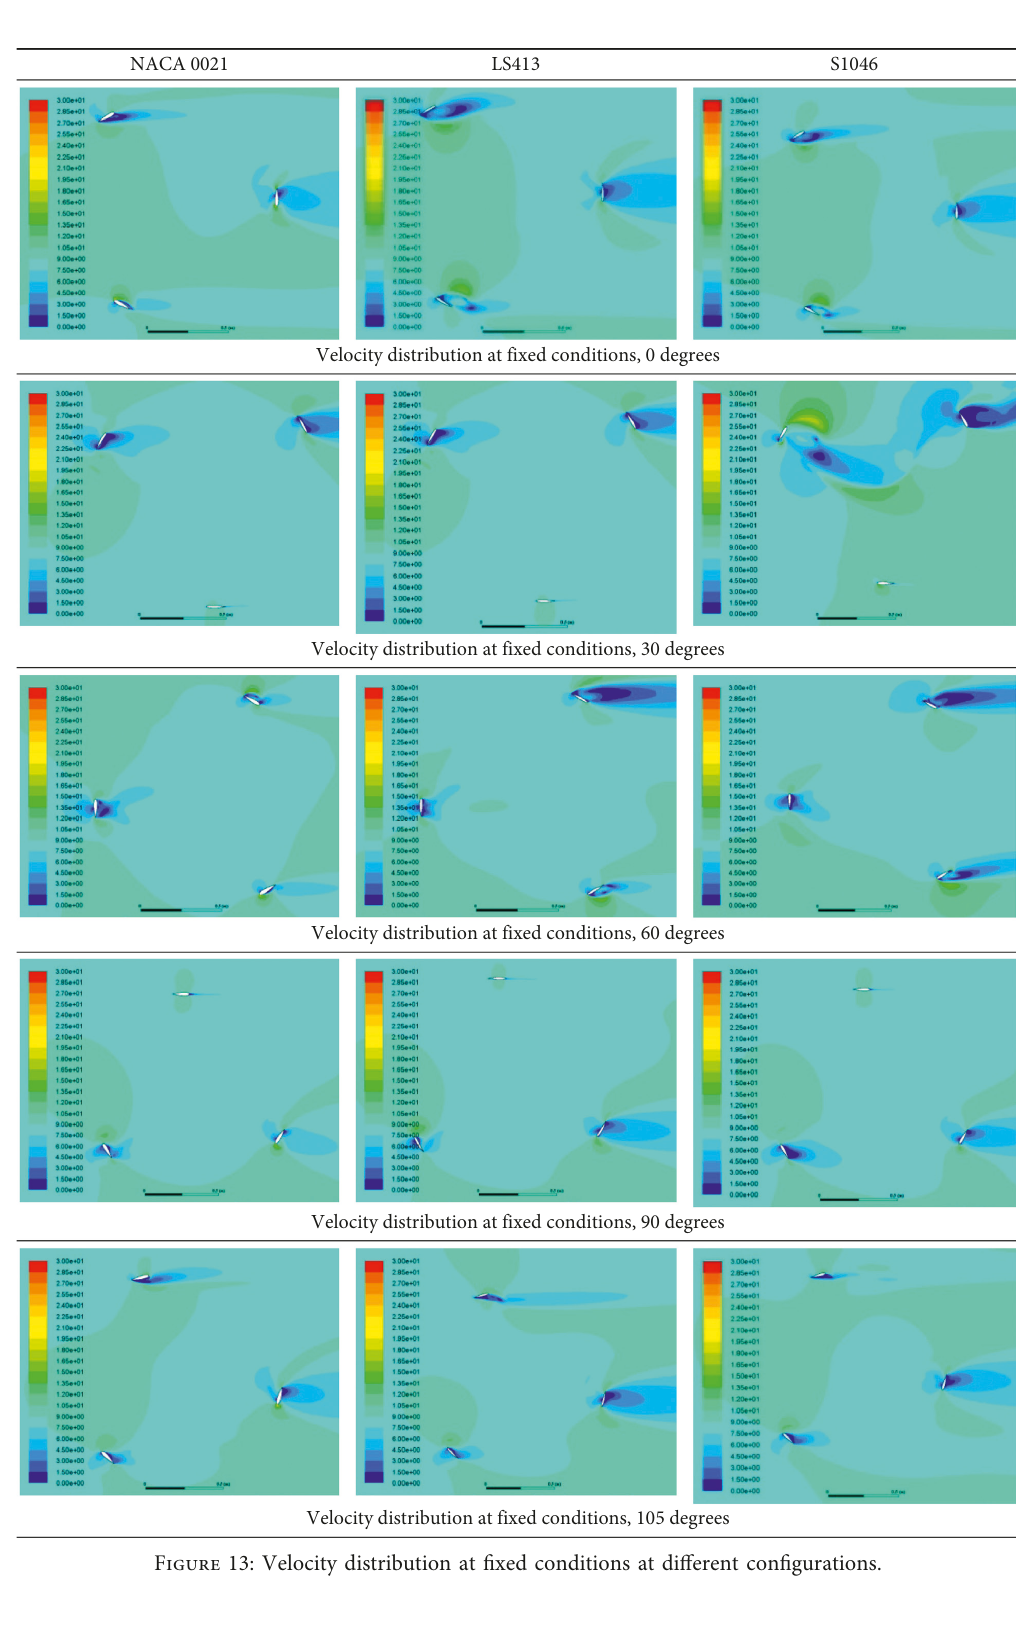
Figure 13: Velocity distribution at fixed conditions at different